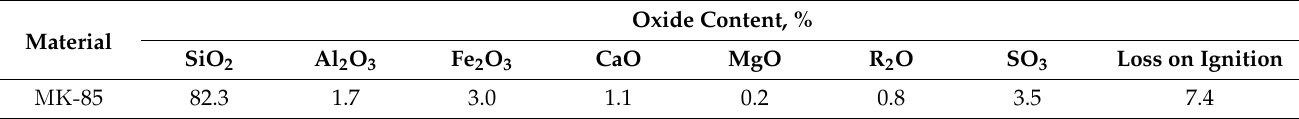
Table 6. Chemical composition of micro silica MS-85.